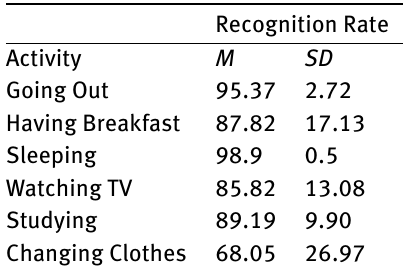
Table 3: Average and standard deviation values for recognition rate using self validation for all days (ARAS